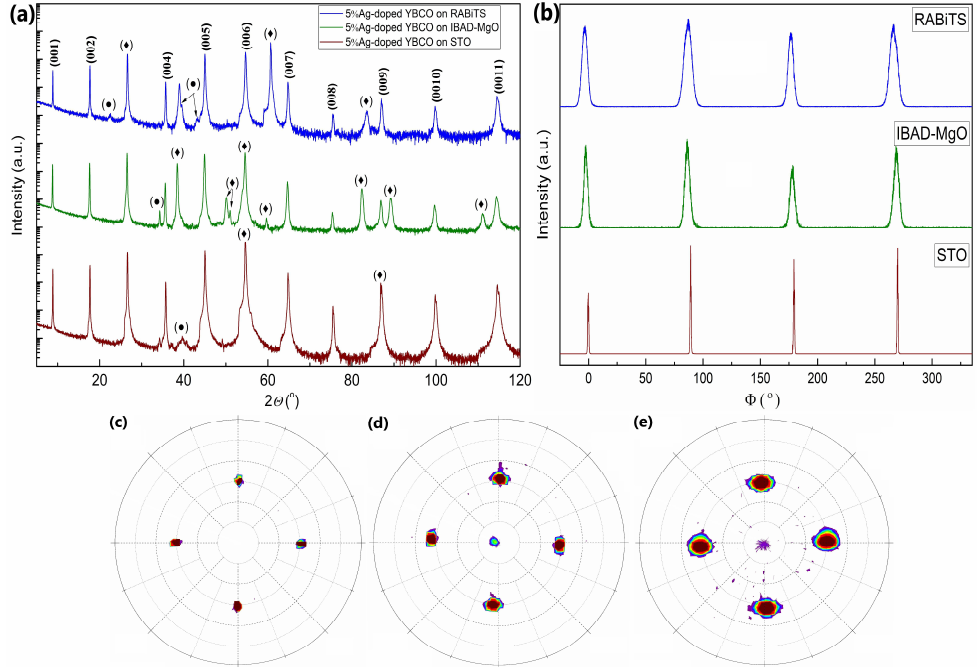
Figure 4. XRD patterns for 5% Ag−doped YBCO films on STO, RABiTS, and IBAD−MgO templates. ( a ) Standard θ–2θ XRD scans. The symbol ( ◆ ) indicates the peaks of the substrate and buffer layers, whereas (●) indicates additional oxides as NiO, NiWO 4 , and Y 2 O 3 ; ( b ) in−plane scans of the YBCO (103) reflection. Pole figures of the YBCO (103) planes for the 2%Ag−doped YBCO films on ( c ) STO, ( d ) IBAD−MgO, and ( e ) RABiTS.